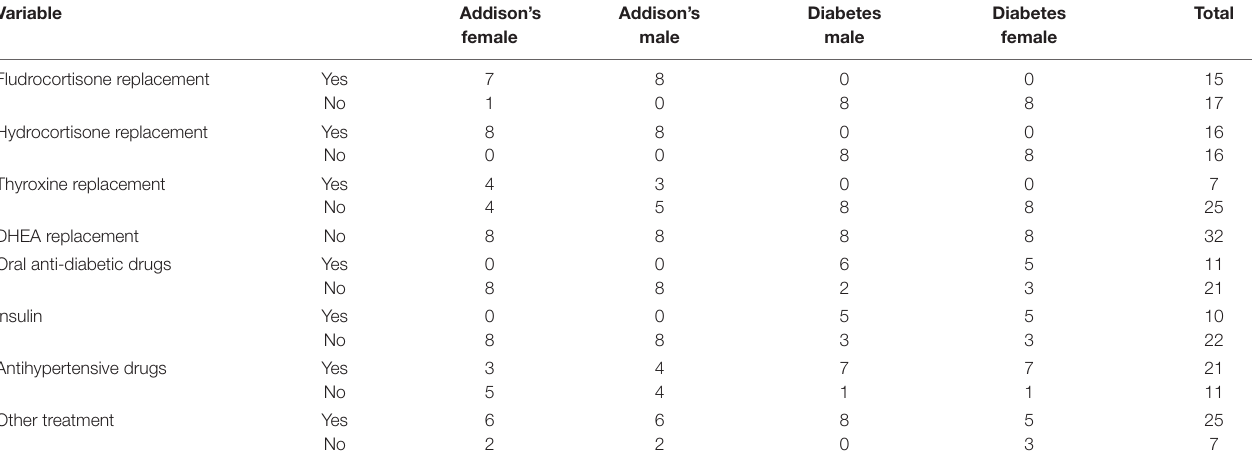
TABLE 2 | Description of medical treatment for the Addison’s patient group and the type 2 diabetes group. Variable Addison’s